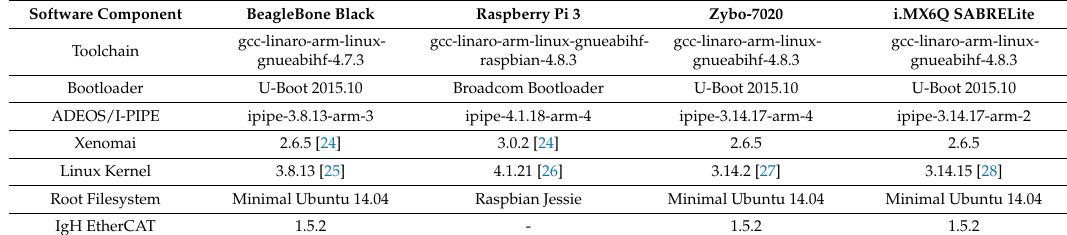
Table 1. Real-time environment and the compatible version of each software components for the respective open embedded